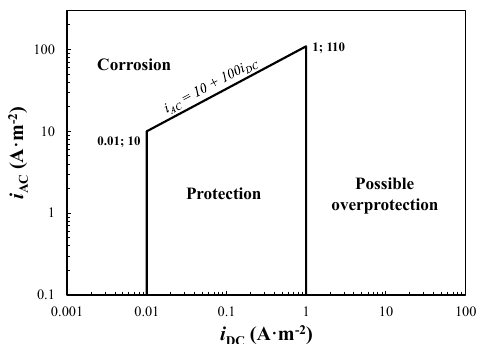
Figure 5. Acceptable AC interference levels based on current densities criterion according to He et al. (adapted from [24]).